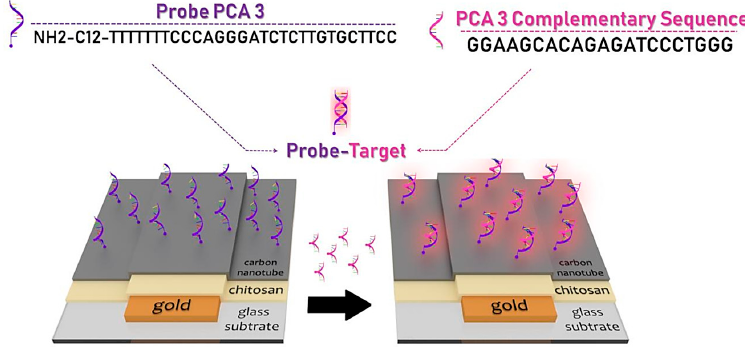
Figure 9. Nano-platform biosensor manufacturing scheme based on carbon nanotubes (MWCNT) for detection of prostate cancer antigen 3 (PCA3). Reproduced from [169] with permission from American Chemical Society, 2019.